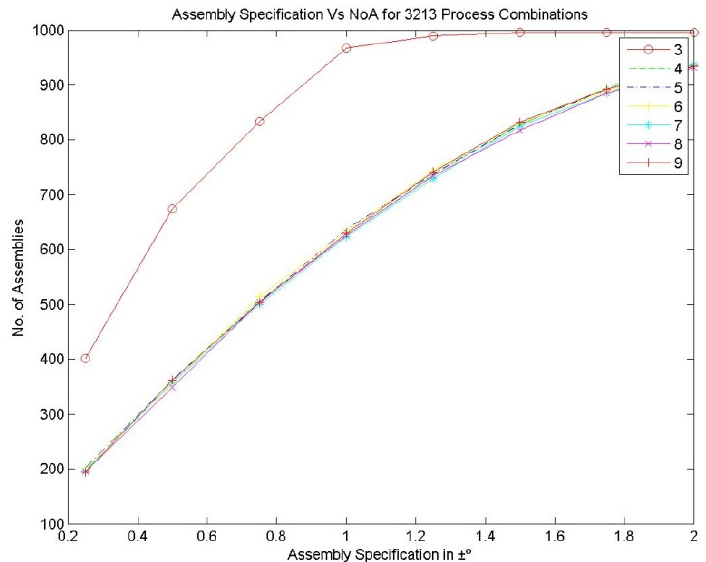
Figure 7. Assembly specification vs. NoA for various bin numbers—the 3213 process